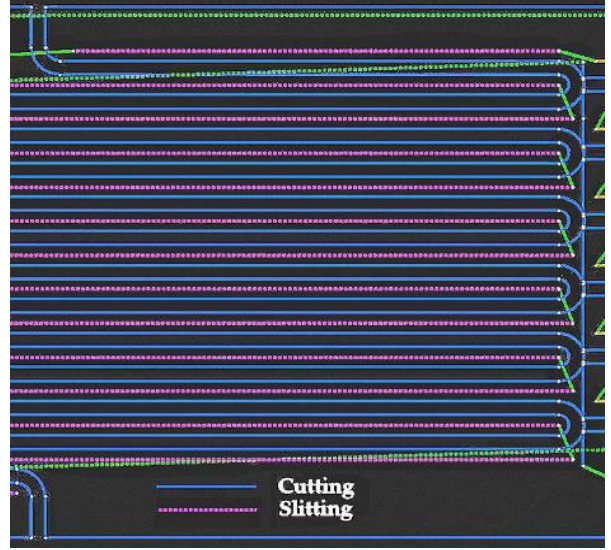
Figure 18. Tool path for U-U cutting mode.